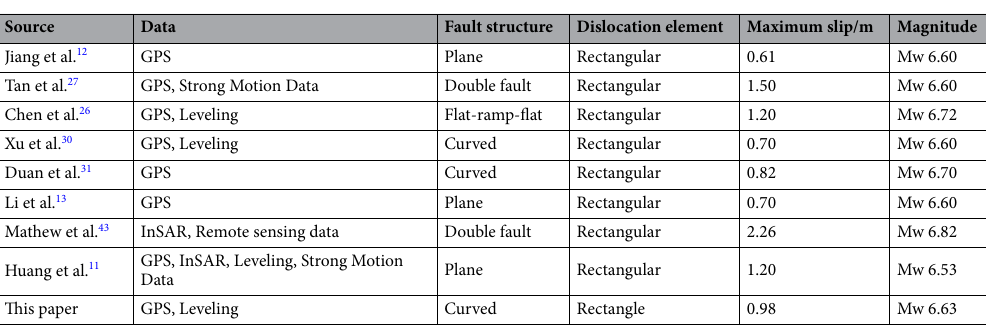
Table 2. Rupture parameters of the Lushan